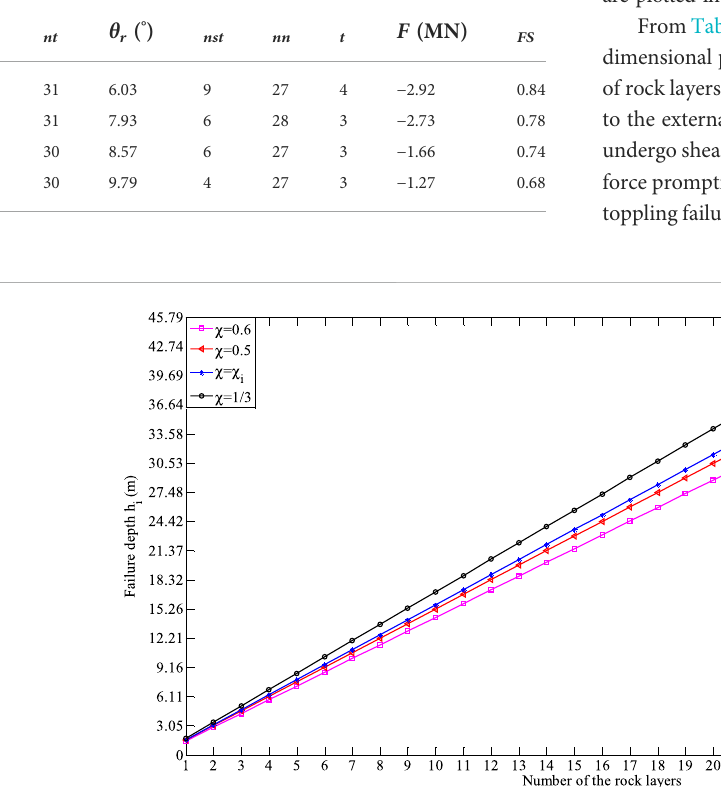
TABLE 5 The results obtained through the presented framework for different values of χ